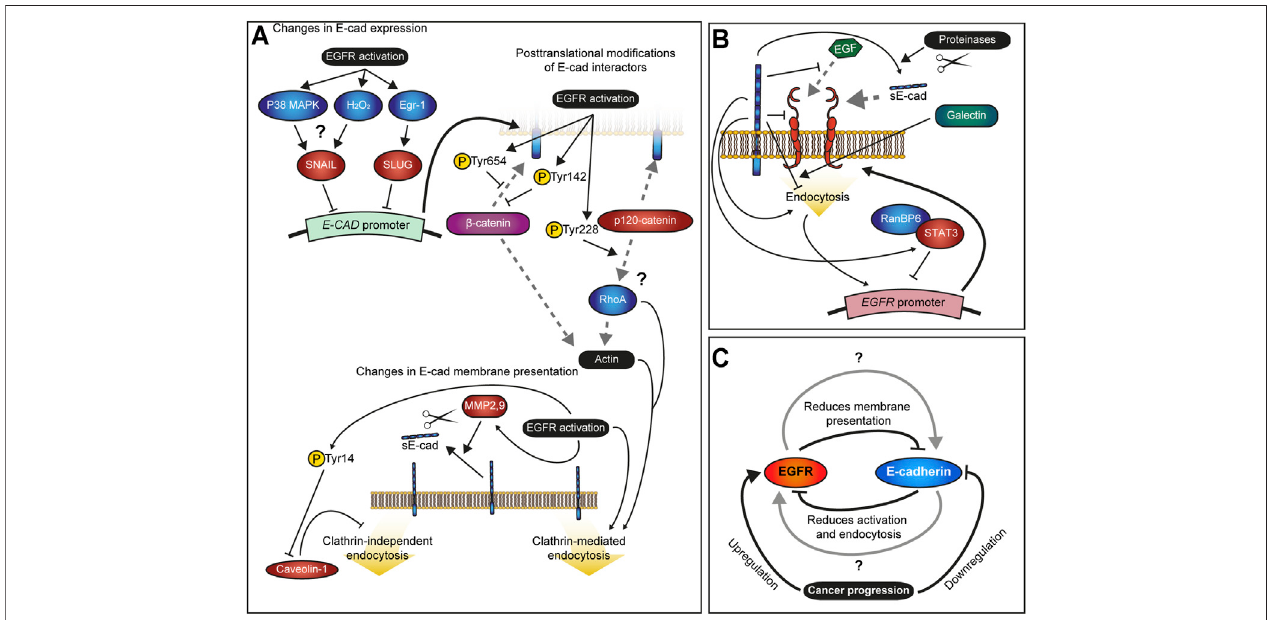
FIGURE2| Interactions betweenEGFRand E-cadherin. (A) – SummaryoftheknowneffectsofEGFR activationonE-cadherin. EGFRsignallingdownregulates E- cadherin (E-CAD) gene expression via the transcriptional repressors SNAIL and SLUG. By promoting phosphorylation, it also destabilizes membrane E-cadherin by reducing its af fi nity with β -catenin and the subsequent connection to the actin cytoskeleton as well as alters interactions between p120-catenin with RhoA. Additionally, EGFR signalling increases E-cadherin endocytosis by blocking Caveolin-1 activity, a negative regulator of the EGFR pathway itself, and promotes processing of E-cadherin into soluble E-cadherin (sE-cad) through activation of the Matrix Metalloproteinases (MMPs) 2 and 9. Grey dashed lines indicate protein binding. (B) – Summary of the known effects of E-cadherin on EGFR. E-cadherin stabilizes EGFR at the membrane, blocks its activation by EGF and reduces its internalization. Through STAT3 and RanBP6, E-cadherin represses EGFR gene expression. Additionally, sE-Cad is an agonistic ligand of EGFR, and therefore E-cadherin cleavage, which is promoted by EGFR activity, positively regulates EGFR signalling. (C) – Model of the feedback mechanism between EGFR activity and E-cadherin; the negative feedback loop between the two leads to stable EGFR activation and loss of E-cadherin in cancer cells. Gray arrows indicate unknown mechanisms by which both transmembrane proteins coexist and fi ne-tune each other in normal tissue during development and homeostasis.